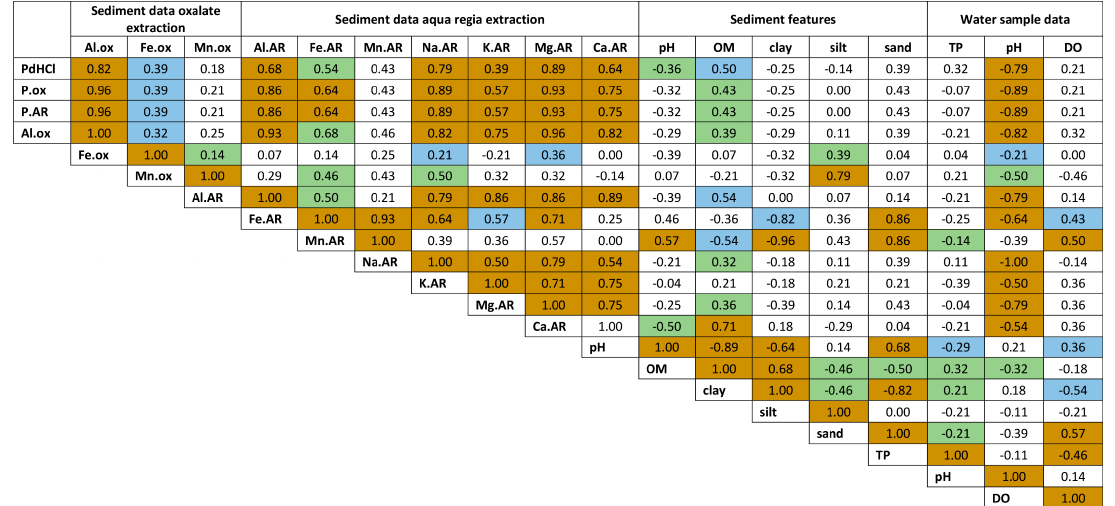
Figure A1. Spearman correlation of sediment and water data for Sampling 1 (5 November 2018). p ≤ 0.05 (green), p ≤ 0.01 (blue) and p ≤ 0.001 (brown), not significant (no color). Soil Syst. 2020 , 4 , x FOR PEER REVIEW